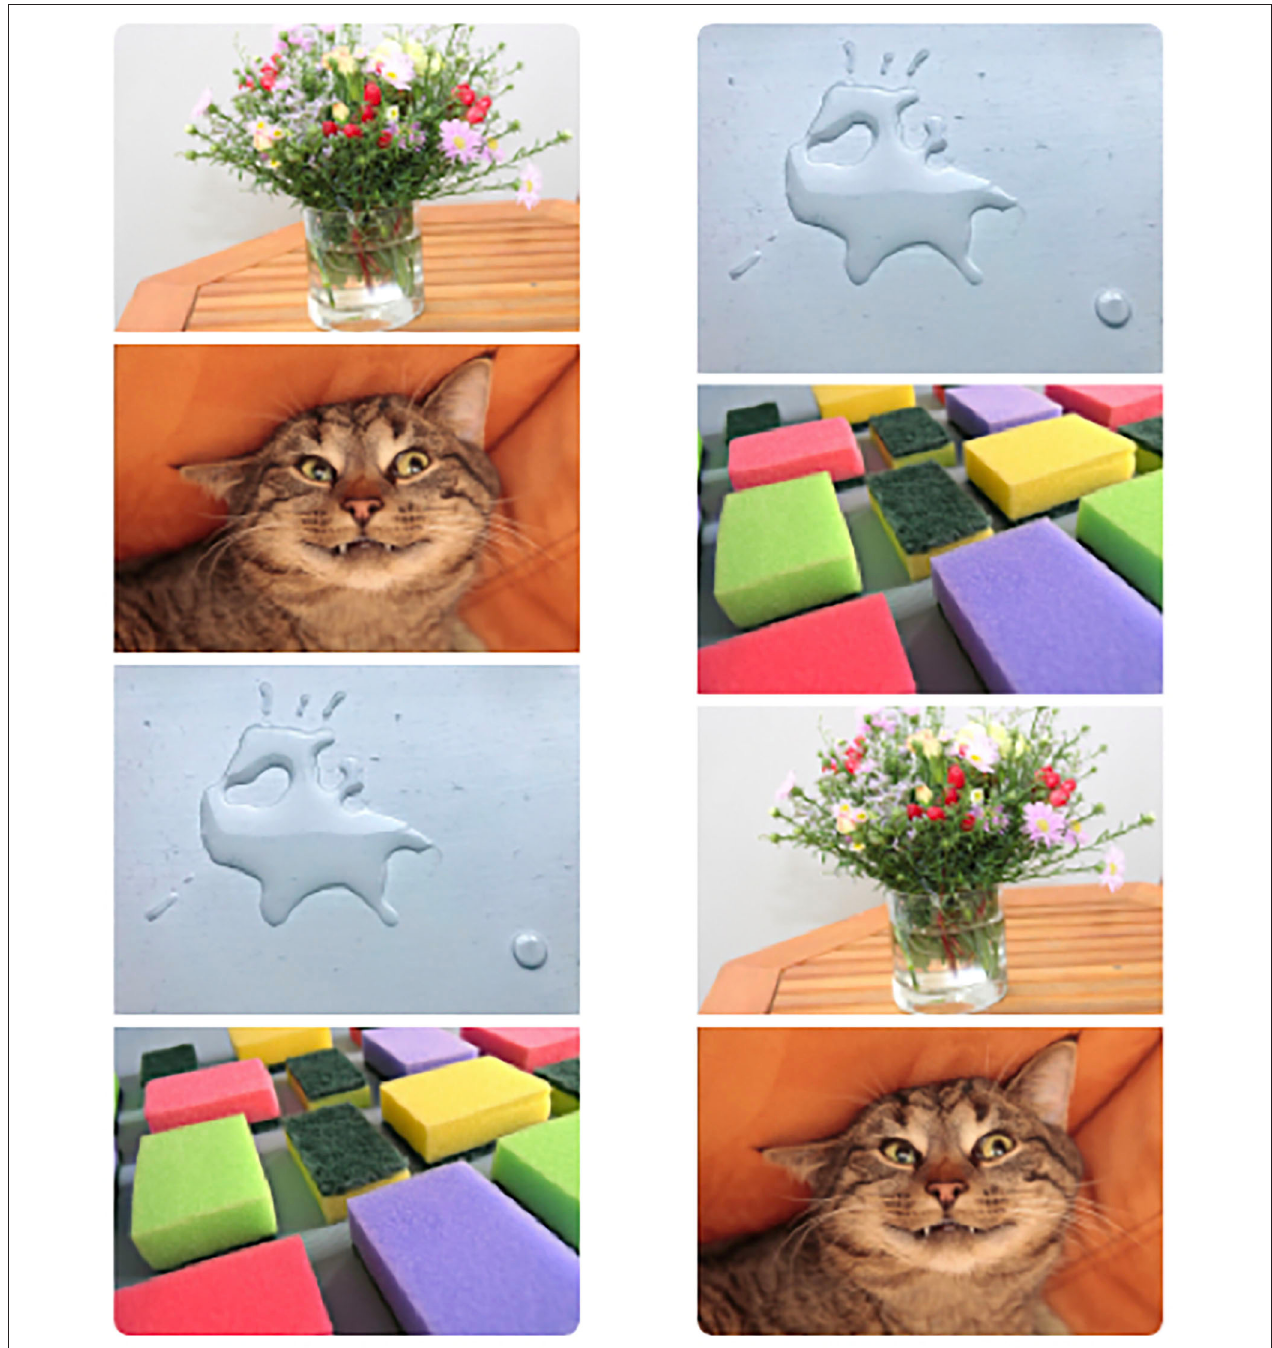
FIGURE 1 | Example of a flip: a meaningful story (Left) and a meaningless sequence of pictures (Right) . Idena Network, 2020. Pseudonym